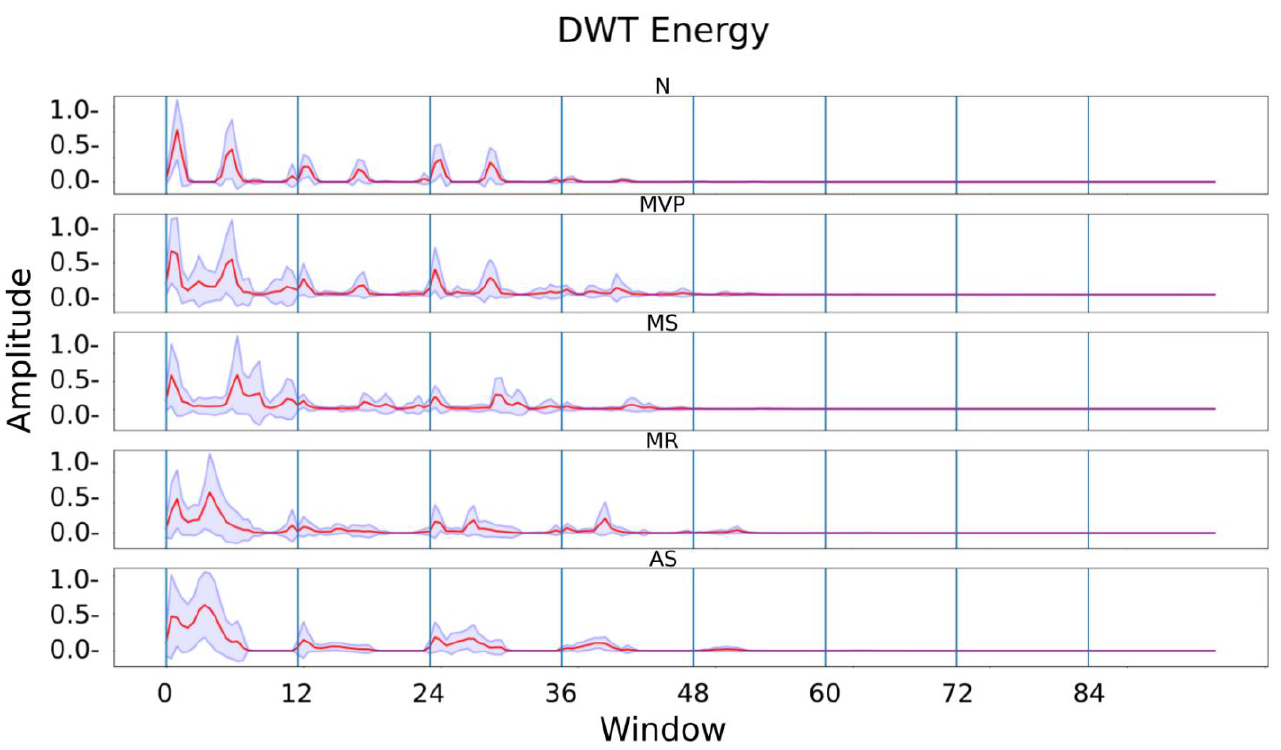
Figure 6. Computation of mean entropy and energy. The levels of decomposition are divided by vertical lines (reused from the public dataset no copyright is required).